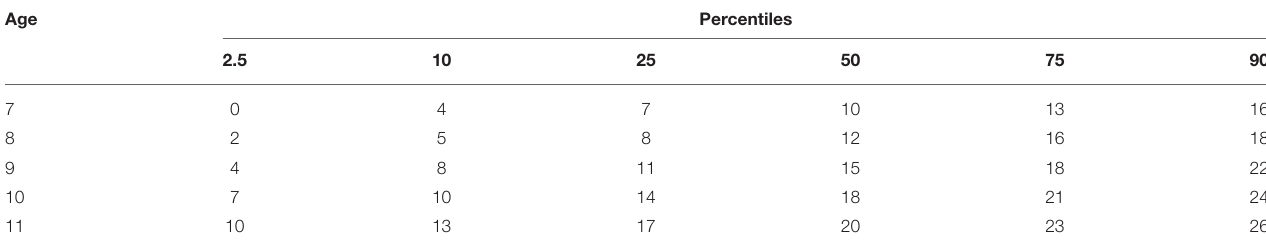
TABLE 5 | Reference-specific age-intervals based on total scores on the instrument.